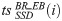
Convergence of SSD and MSD algorithms on the benchmark set BR_EnzBench
enzdes (blue lines) was executed for 1000 runs i on all 20 conformations of each prot(k) from BR_EnzBench.For each number of runs i, the tsSSDBR_EB(i) value (dotted line) is the mean of the twenty lowest-energy sequences (Eq 9). The corresponding nssrSSDBR_EB(i) value (solid line) is the mean recovery value deduced from the same sequences (Eq 8). MSF:GA:enzdes (orange lines) was carried out for 600 generations j on all ensembles using a sequence population of 210. For each generation j, the tsMSDBR_EB(j) value (dotted line) is the mean of the five lowest-energy sequences of each of the four protein-specific ensembles (Eq 13). The corresponding nssrMSDBR_EB(j) value (solid line) is the mean recovery value deduced from the same sequences (Eq 12).